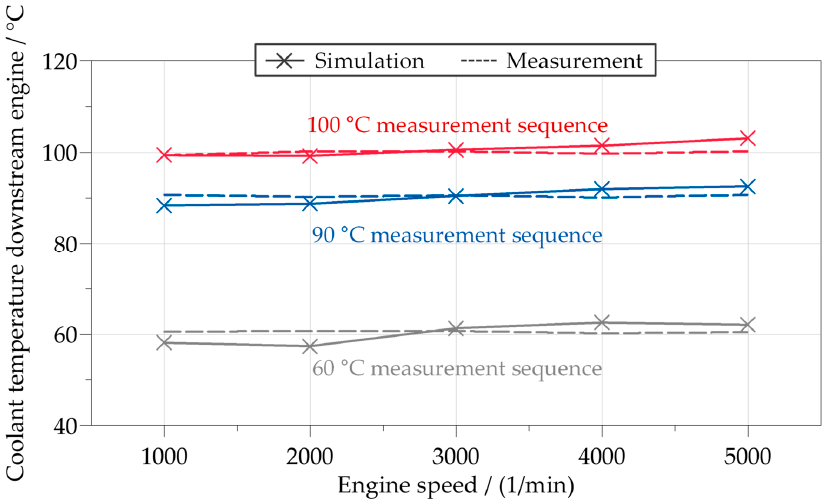
Figure 6. ATMM model validation for coolant temperature variation of T Coolant,ICE,Out = 60 °C, T Coolant,ICE,Out = 90 °C and T Coolant,ICE,Out = 100 °C at engine full load with different engine speeds.